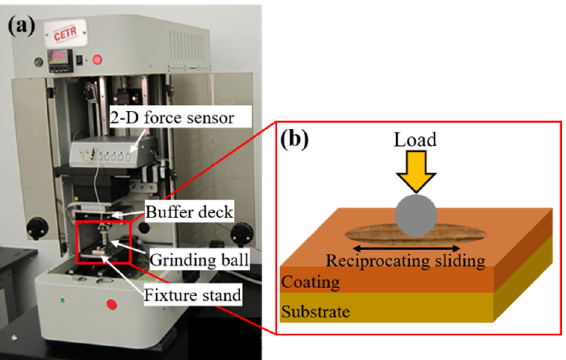
Figure 1. ( a ) Reciprocating ball-on-plate type wear tester, ( b ) schematic illustration of a GCr15 ball sliding on the coating. sliding on the